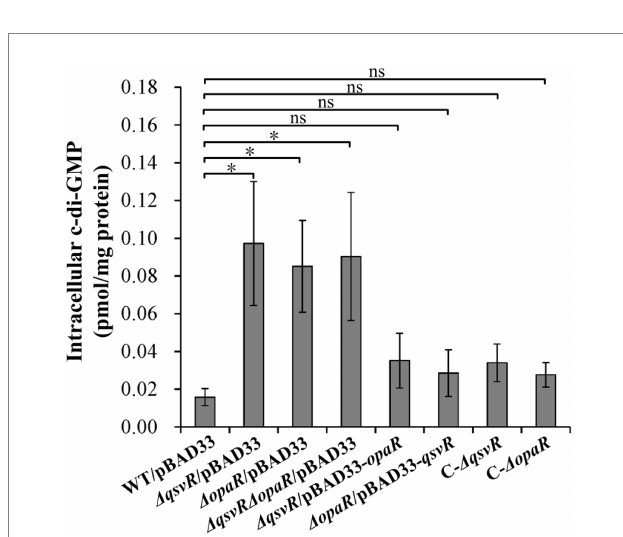
FIGURE 4 Intracellular c-di-GMP levels in different V. parahaemolyticus strains. Bacterial cells were harvested after 6 h of incubation at 37 ° C on HI plates. c-di-GMP levels were determined using a c-di-GMP enzyme- linked immunosorbent assay (ELISA) kit. The data are expressed as the means ± SD of at least three independent experiments. The asterisks indicate statistical significances relative to WT/pBAD33 ( p < 0.01). The ‘ns’ means no significant differences ( p >